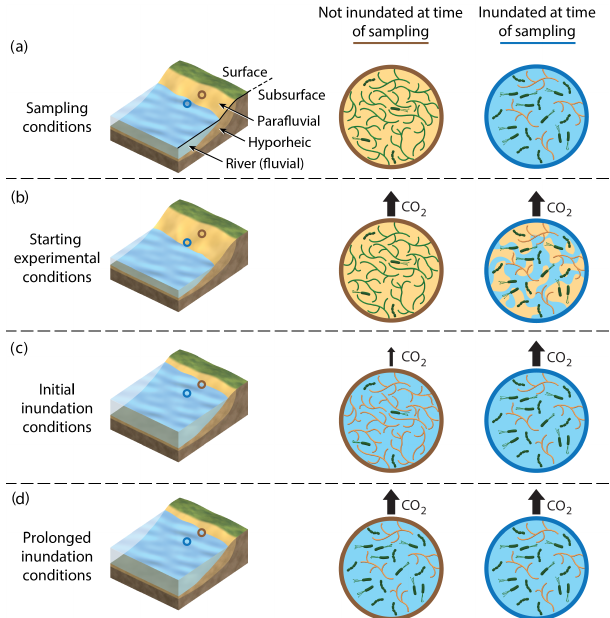
Figure 6. Illustration of field conditions during sampling (a) and of incubation conditions prior to experimental inundation (b) , during initial inundation (c) , and following prolonged inundation (d) . River elevation diagrams (far left) display field conditions replicated by the incubation experiments. In historically uninundated sediments (middle), fungi (branching organisms) perform well (green) (a, b) but are metabolically suppressed (orange) upon initial re-inundation (blue shading), leading to lower CO 2 flux (thin arrow) (c) . We pro- pose that prolonged inundation shifts the community towards bac- terial (rod shapes) dominance, leading to an eventual recovery of CO 2 flux (thick arrow) (d) . In historically inundated sediments (far right), bacteria perform well and maintain a higher CO 2 flux both during a brief drop in river stage in which the sediments lack an overlying water column but stay saturated (b) and when water level rises (c, d)